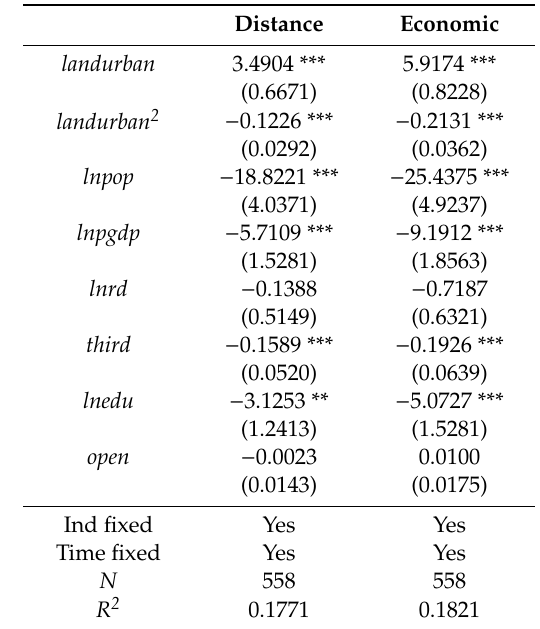
Table A2. SAR panel data model estimated results of di ff erent spatial weight